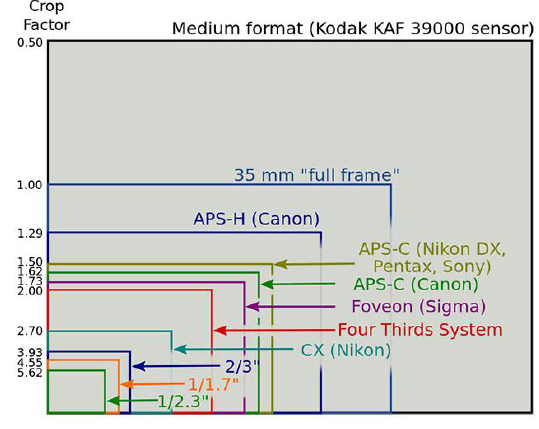
Figure 1. Image sensor size comparison